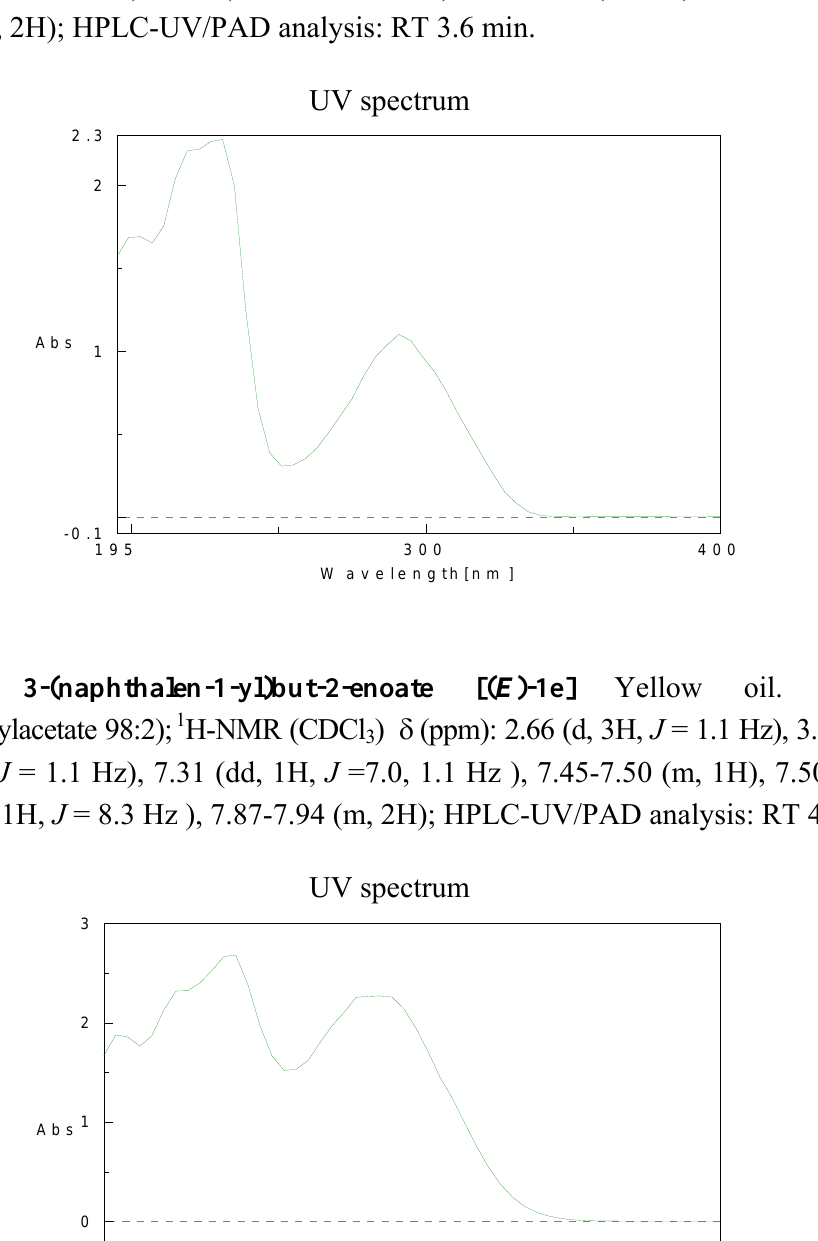
( Z )-Methyl 3-(naphthalen-1-yl)but-2-enoate [( Z )-1e] Yellow oil. R ( n -hexane/ethylacetate 98:2); 1 H-NMR (CDCl 6.24 (q, 1H, J = 1.4 Hz), 7.21 (d, 1H, J =7.0Hz ), 7.60-7.67 (m, 1H), 7.72-7.83 (m, 3H), 7.95-8.05 (m, 2H); HPLC-UV/PAD analysis: RT 3.6 min.